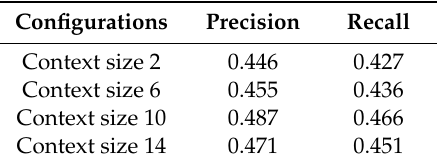
Table 4. The results of di ff erent context